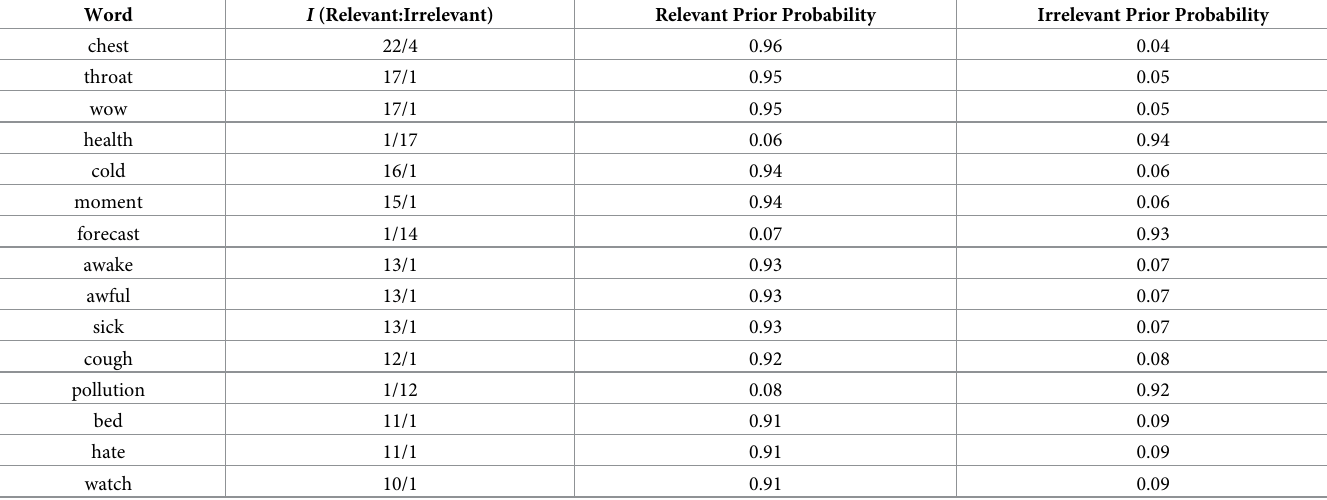
Table 12. Most informative words measured by their Informativeness and their relevant:irrelevant prior probabilities. Word I